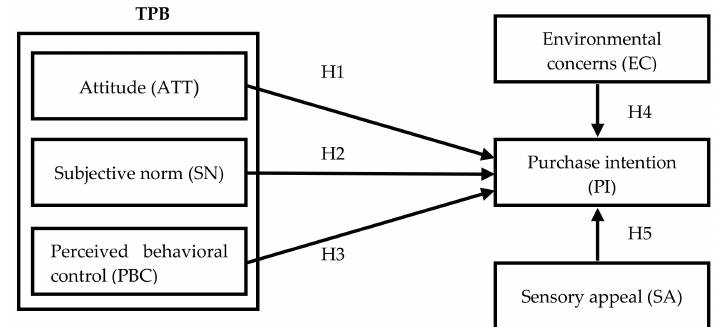
Figure 2. Conceptual framework and hypotheses of the study. H 1 . ATT will positively affect PI; H 2 . SN will positively affect PI; H 3 . PBC will positively affect PI; H 4 . EC will positively affect PI; H 5 . SA will positively affect